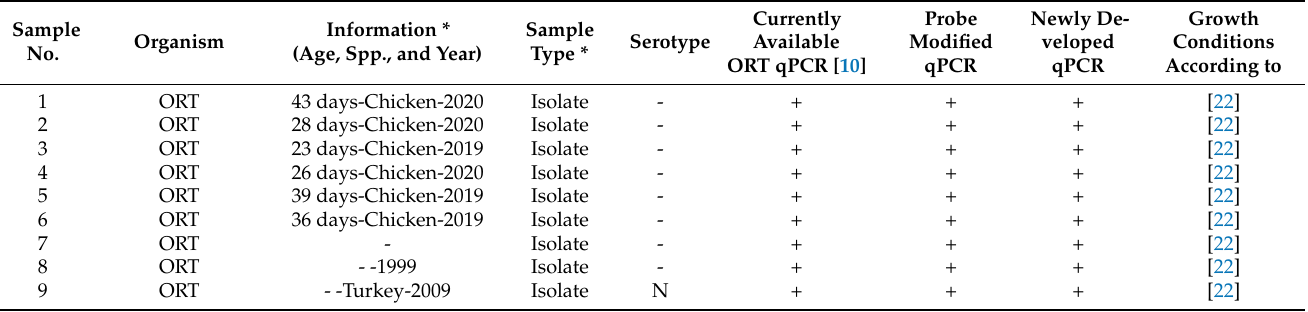
Table 2. ORT and other bacterial and viral isolates used to evaluate the analytical specificity of the assays in this